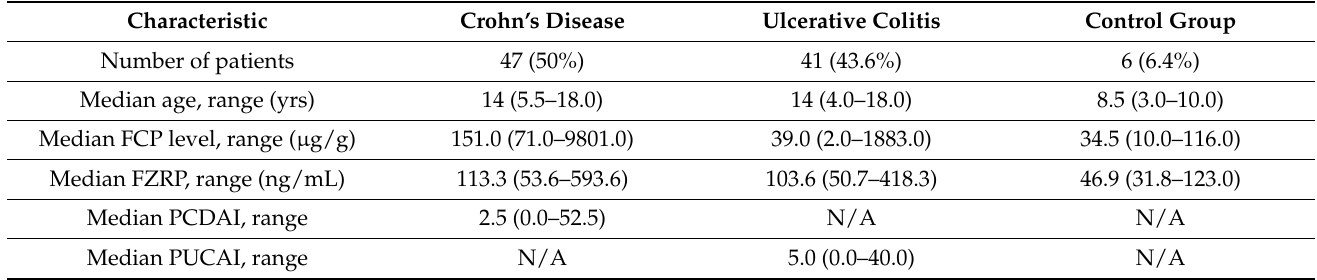
Table 1. Characteristics of the study